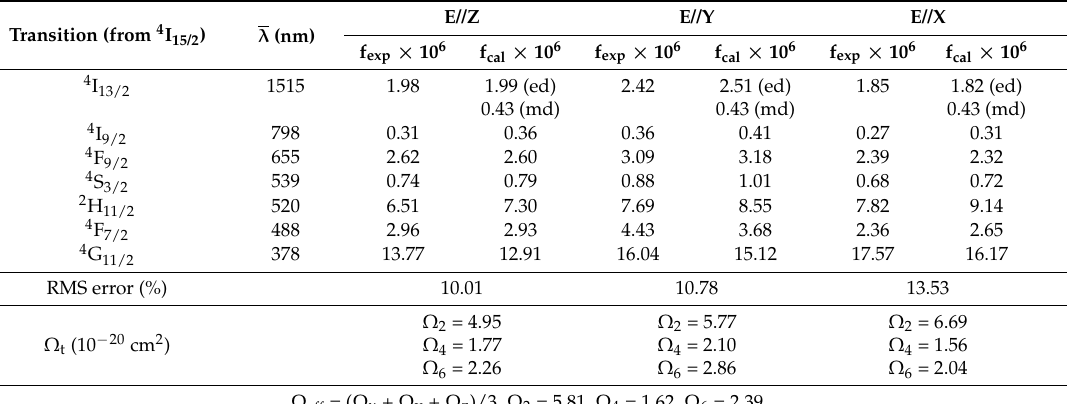
Figure 5. Polarized absorption spectra of Er:Yb:GMB crystal at room temperature. Table 1. Average wavelengths, measured and calculated oscillator strengths, the intensity parameters Ω t of the Er:Yb:GMB crystal.